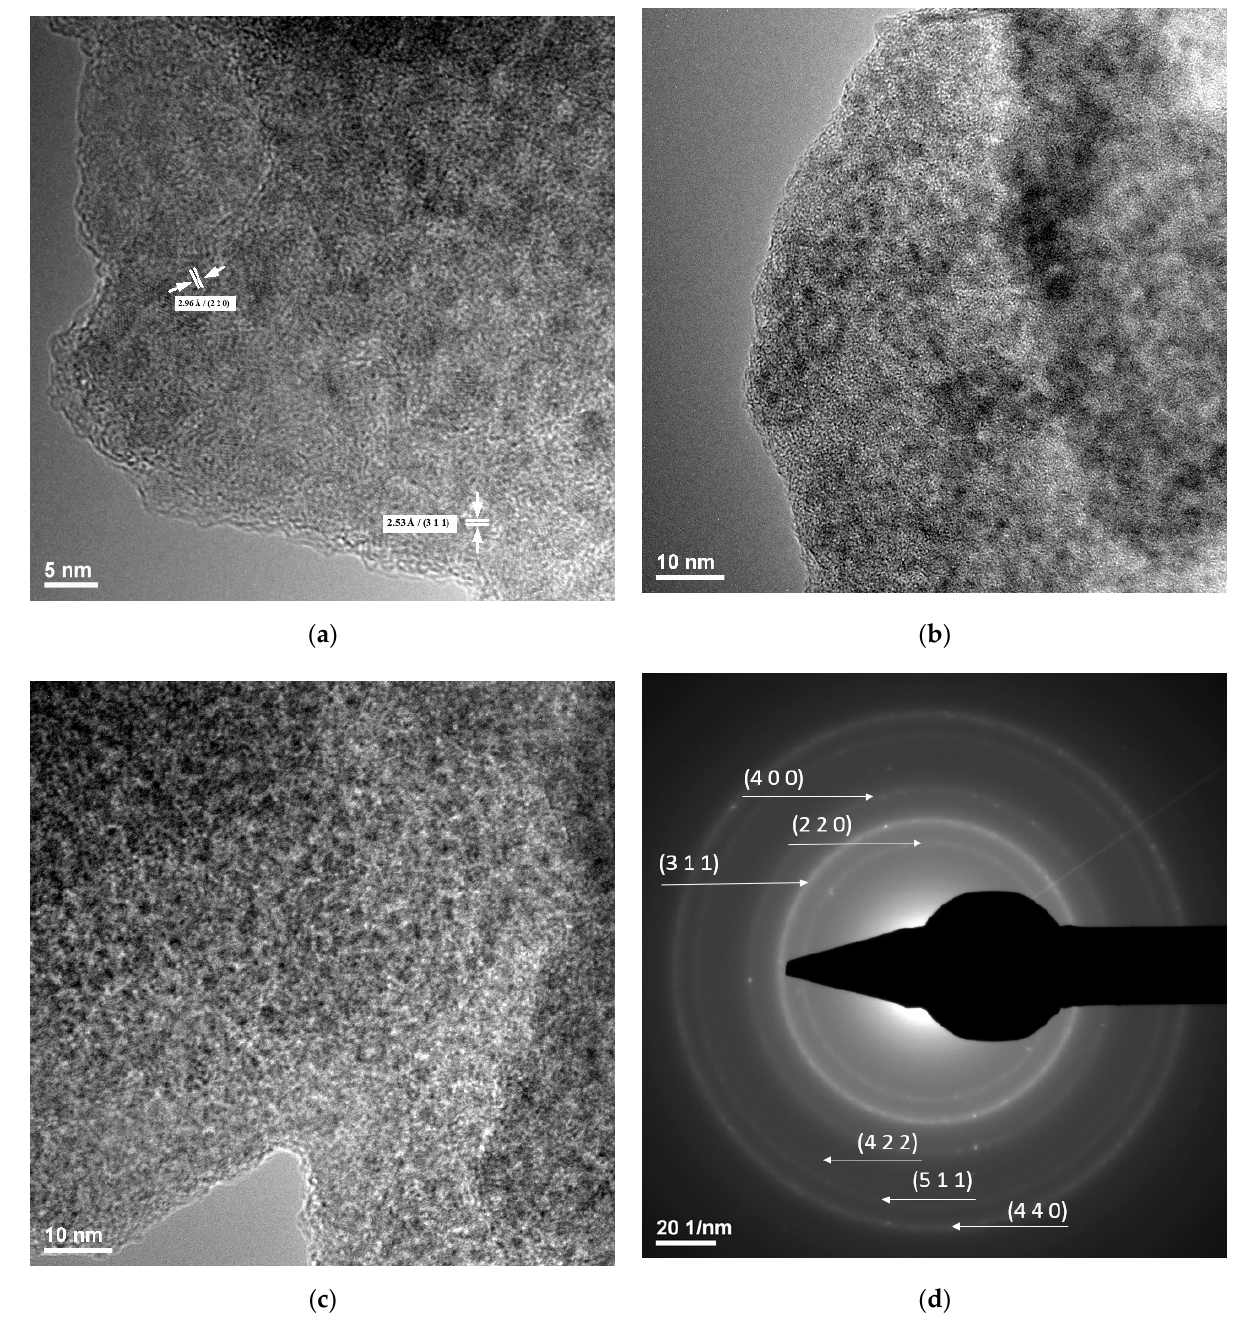
Figure 2. TEM images ( a – c ) and SAED pattern ( d ) of Fe 3 O 4 @CS nanoparticles. The FT-IR analysis highlighted the integrity of the main functional groups of the corresponds to the Fe–O stretching vibrations from the structure of the magnetite; the absorption bands between 1088 and 3368 cm − 1 are generated by the functional bonds from the structure of the chitosan, namely C-O (1088 cm − 1 ), C=O (1637 cm − 1 ), and C-H (2857 cm − 1 and 2931 cm − 1 ). The absorption band that is characteristic to the hydroxyl and amino groups is observed at 3368 cm − 1